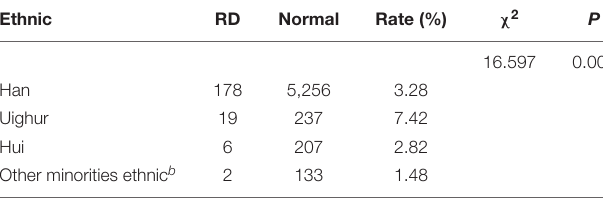
TABLE 3 | The rate of RDs in different ethnicities a .